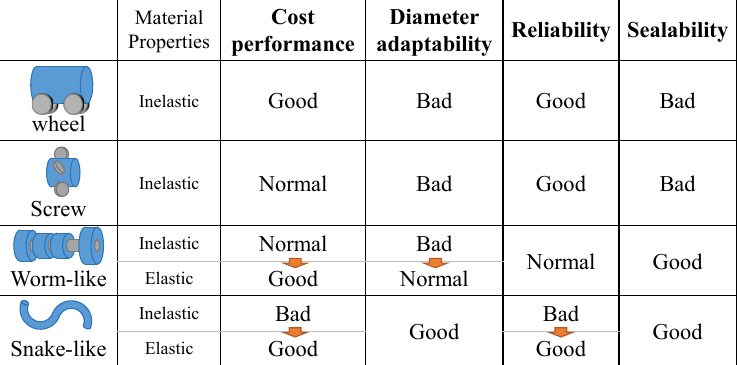
Figure 1. Characteristics of in-pipe